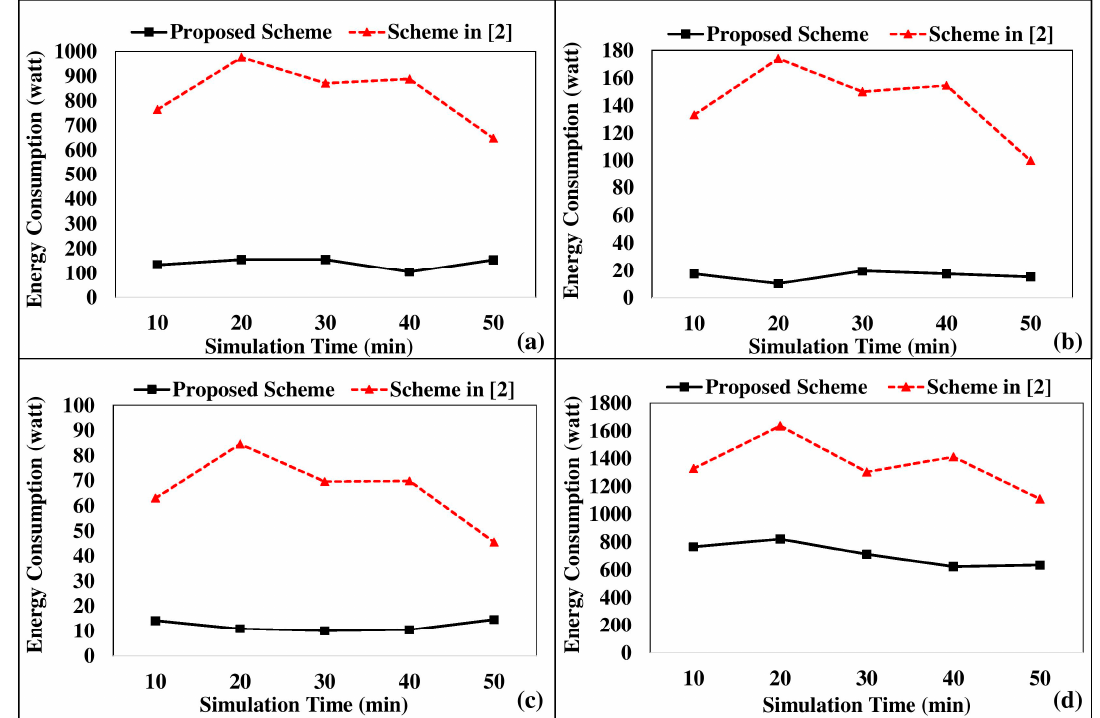
Figure 6. Energy consumption comparison with the scheme proposed in [2]. ( a ) Air conditioner results; ( b ) television results; ( c ) fan results; ( d ) iron results.